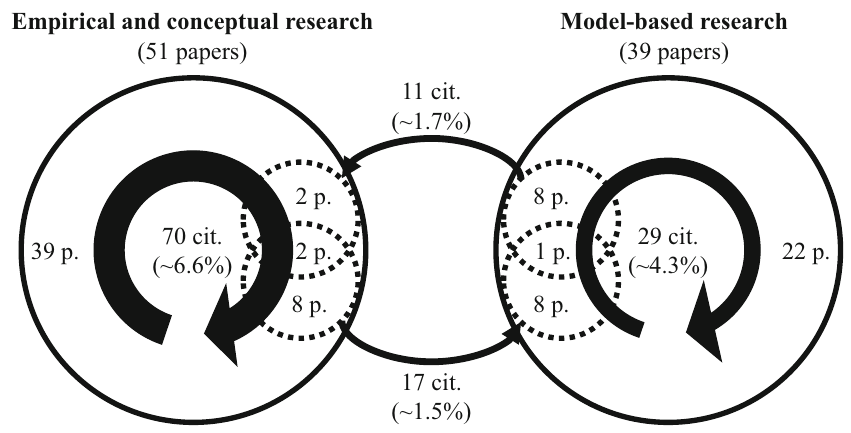
Fig. 2 Citations within and between the two research